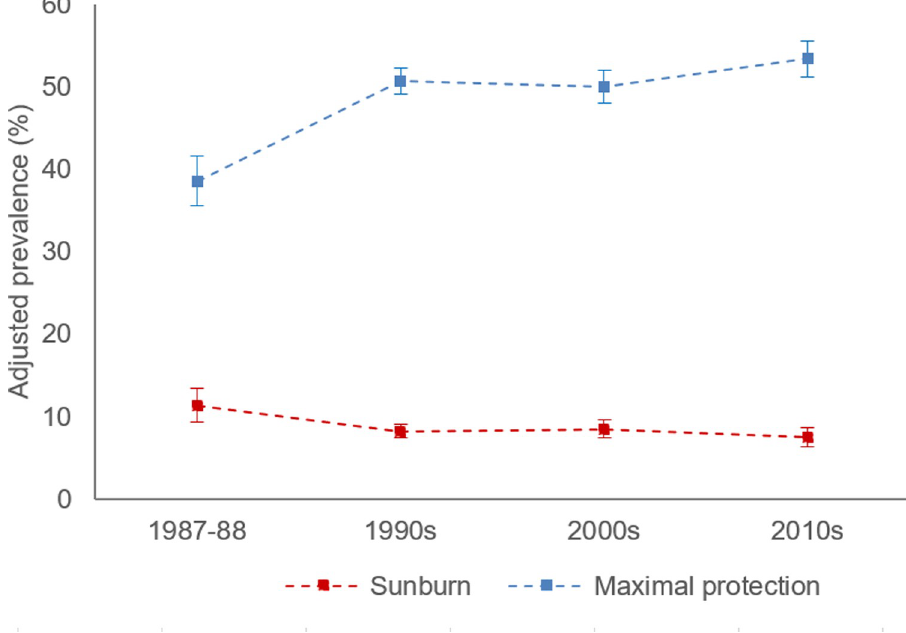
Fig 2. Adjusted prevalence of maximal sun protection and sunburn among Australian adults aged 18–69 years (1987–1988 to 2010s). Data points represent cross-sectional samples from summers in each decade.